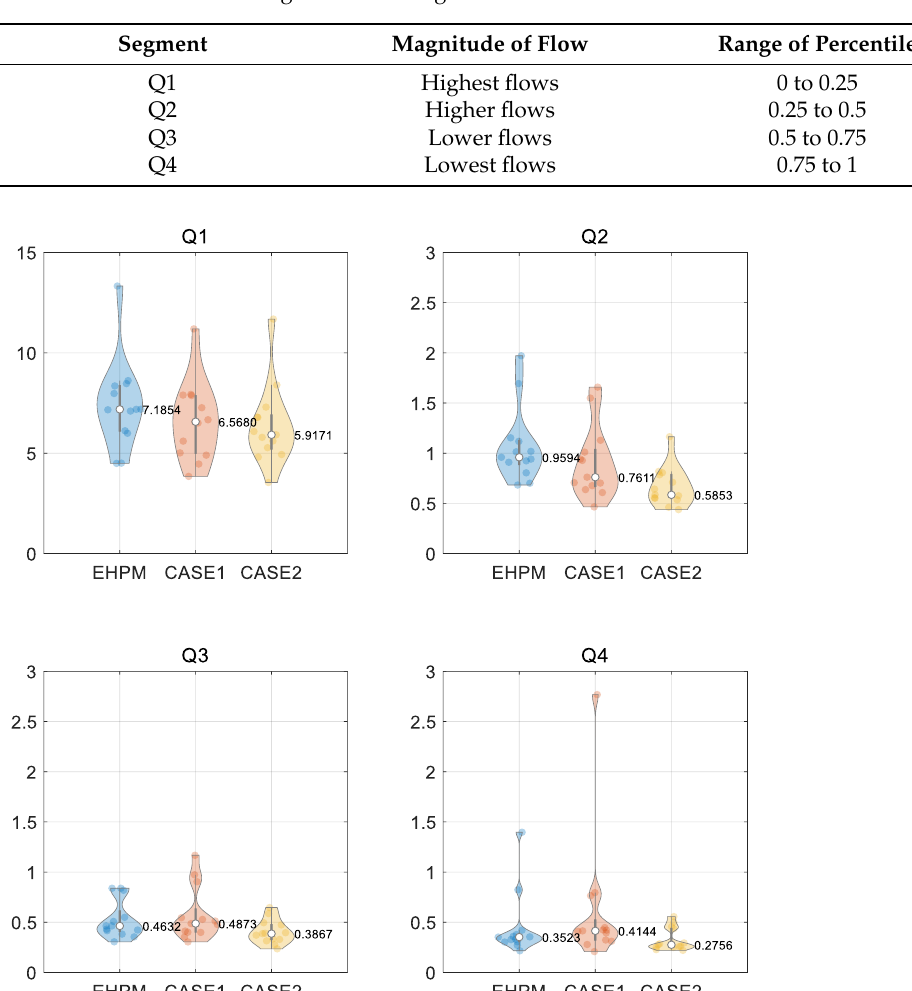
Table 2. Classification of ranges for flow magnitude.